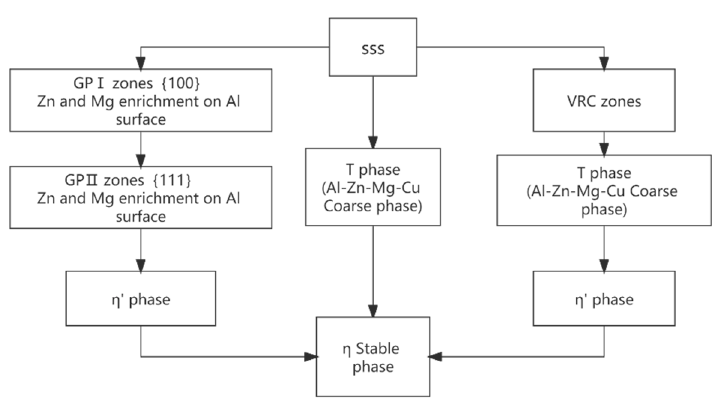
Figure 7. Precipitation sequence of precipitates in 7xxx series aluminum alloy. Adapted with permission from ref. [48]. 2018 Zhang and Deng. Table 4. Morphology and structure characteristics of main precipitates in 7xxx series aluminum alloy [50–54].